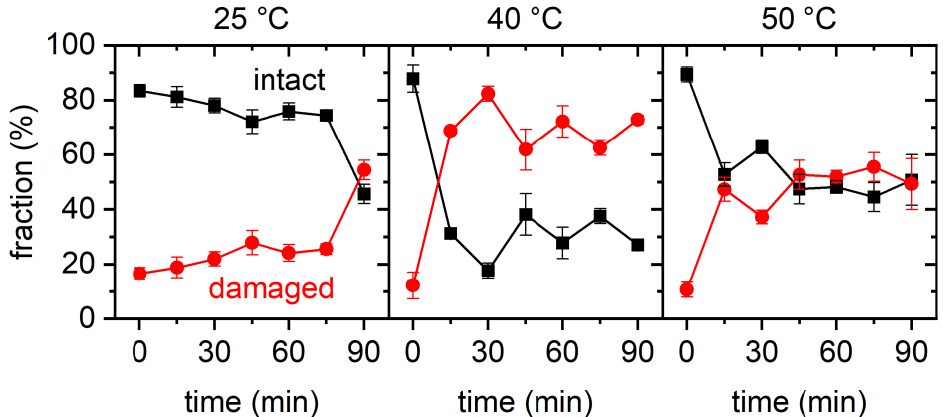
Figure 4. Results of the statistical analysis of the AFM images for 2 M Gdm 2 SO 4 . Each data point represents the average of three AFM images with the standard deviations given as error bars.